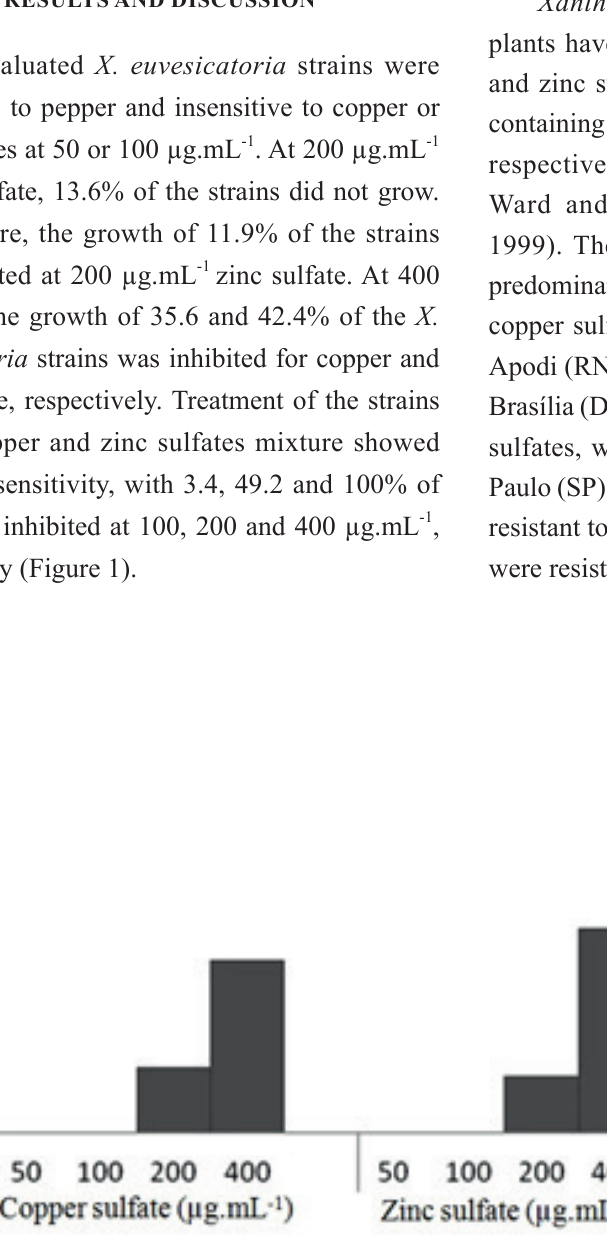
Figure 1 - In vitro sensitivity of Xanthomonas euvisatoria strains from pepper to copper sulfate, zinc sulfate and a mixture of copper and zinc